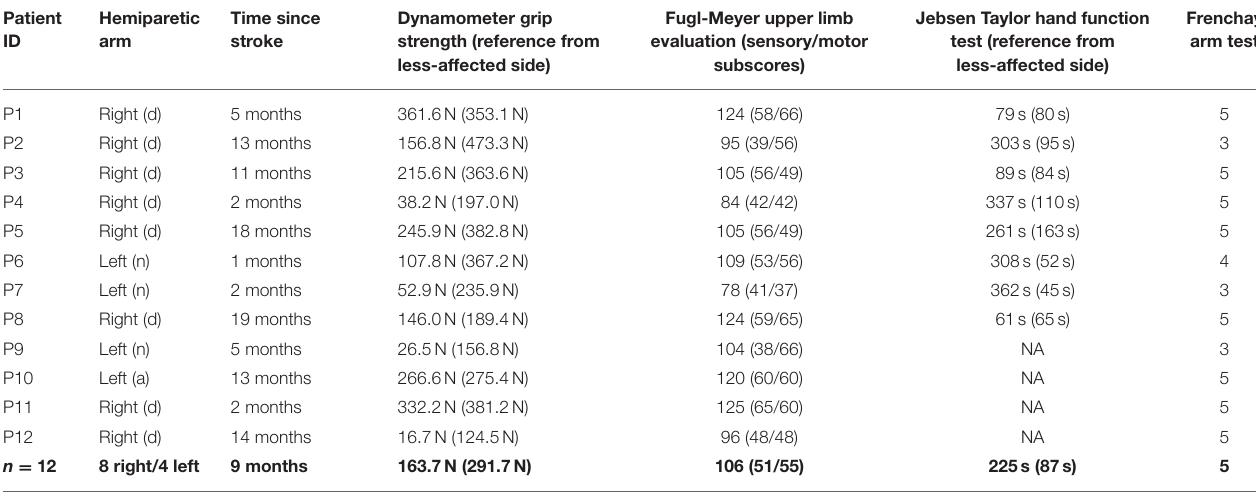
Frenchay arm test